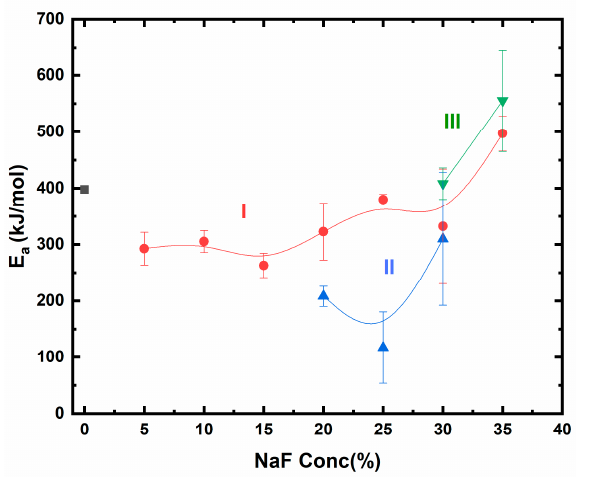
Figure 7. The activation energy of crystal growth for different crystalline phases observed in Fig- ure